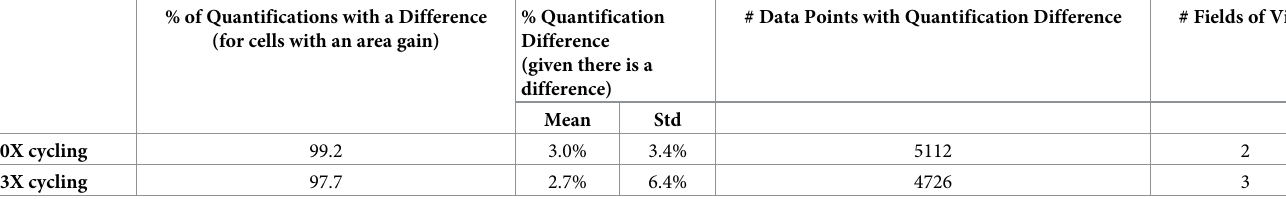
% Quantification # Data Points with Quantification Difference # Fields of Difference (given there is a difference)